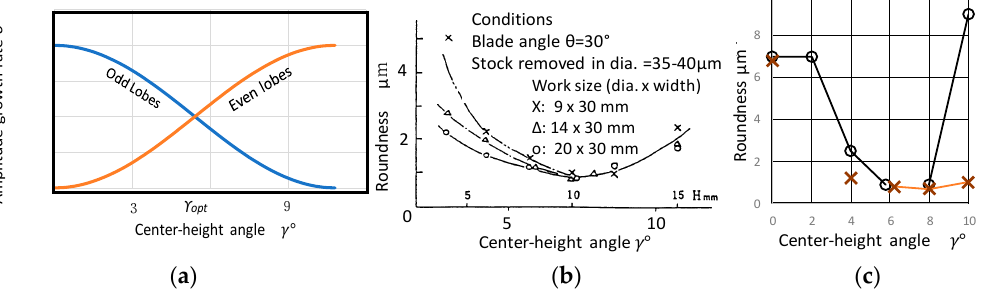
Figure 8. Geometrical rounding stability. ( a ) Center-height angle vs. amplitude growth rates [14]; ( b ) Effect of γ on roundness [6]; ( c ) Effect of γ on roundness [16].